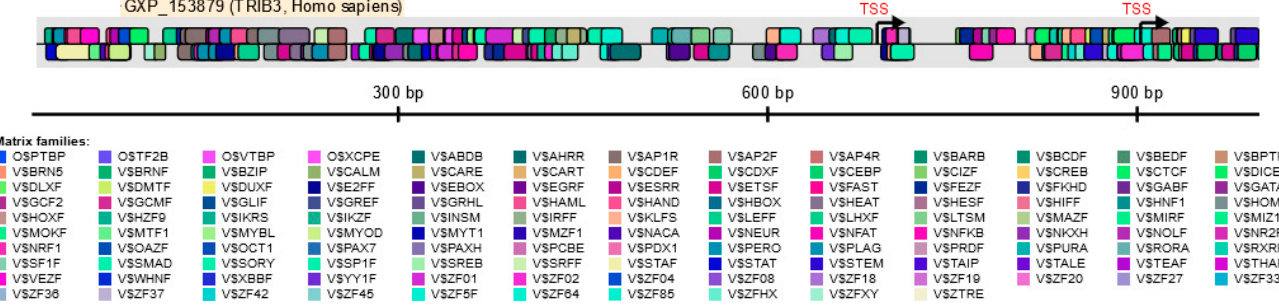
Figure 4. In silico analysis of the human TRIB3 promoter region using the MatInspector Software (Genomatix Software GmbH, Munich; version v3.13). The matching transcription factor binding sites with a 5 ′ to 3 ′ (above the line) or a 3 ′ to 5 ′ (below the line) orientation relative to the transcription start site (TSS) are indicated.